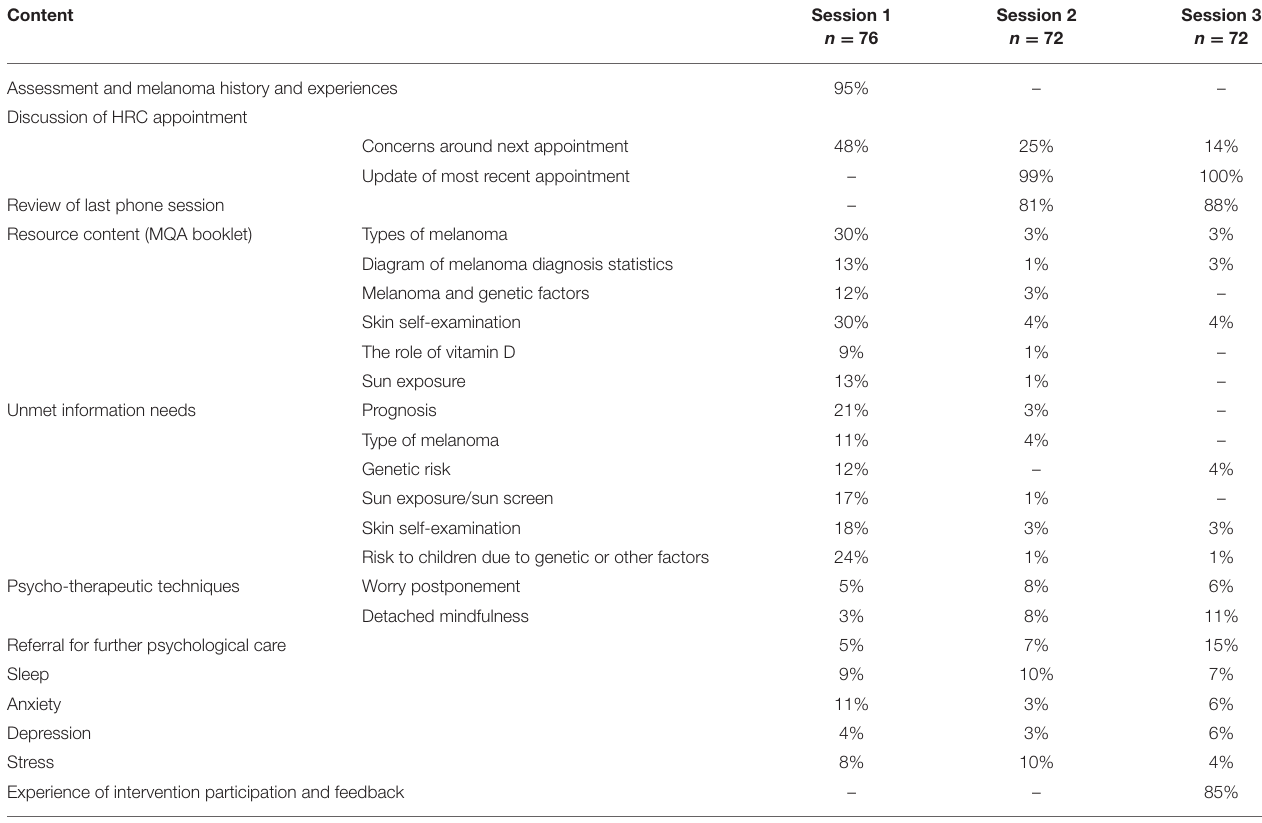
TABLE 1 | Content of telehealth-based psychotherapeutic sessions and the proportion of participants who received this content.